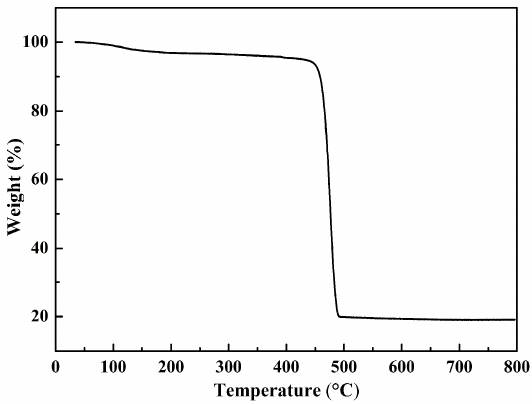
Figure 5. The thermogravimetric analysis (TG) curve of as-synthesized JUC-112.